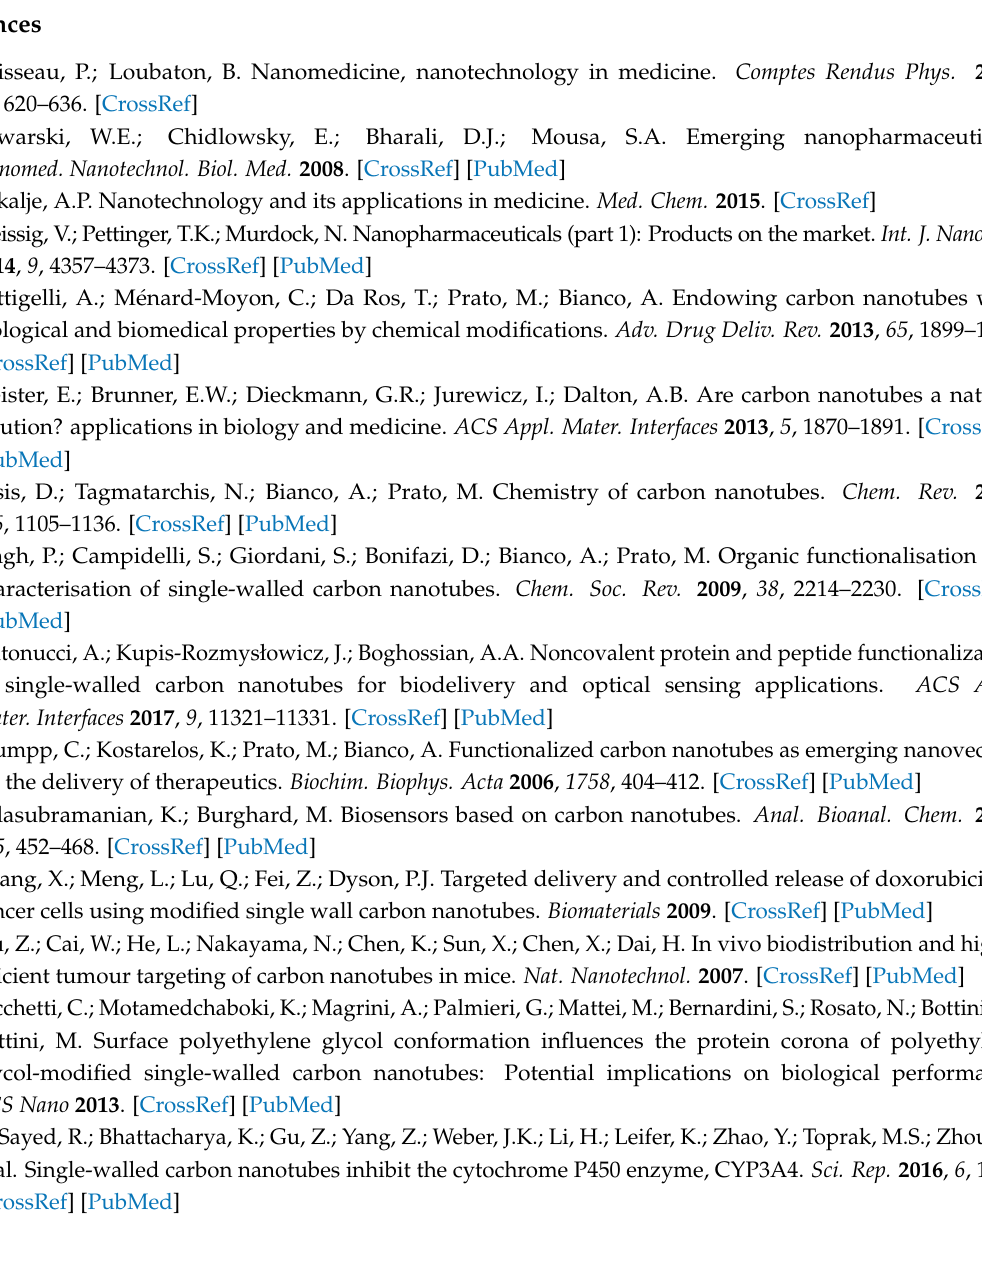
Figure S1. Qualitative study results obtained from MALDI-TOF spectrum to reveal insulin is degraded by pepsin when PEGylated SWCNTs are just mixed with insulin (without sonication). Figure S2. Insulin release (ng/ µ L and %) by serum proteins from the designed functional dispersion with incubation time. All data are represented in the